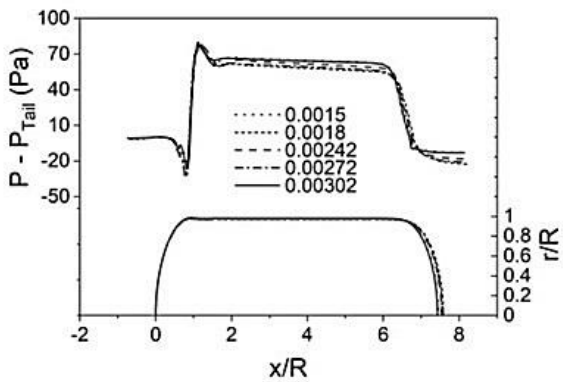
Figure 7. Variation of wall pressure and droplet shape along the axial length of the channel for different Capillary number at β=0.735 when the minimum pressure near the tail of the droplets is transformed to zero and the tails of the droplets are made